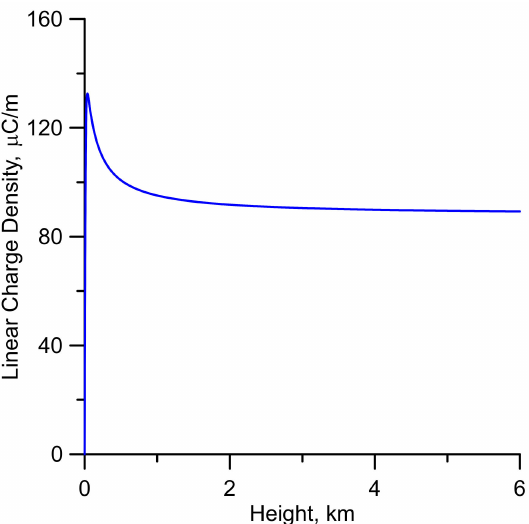
Figure 1. The charge deposited by a 12-kA subsequent return stroke as given by Equation